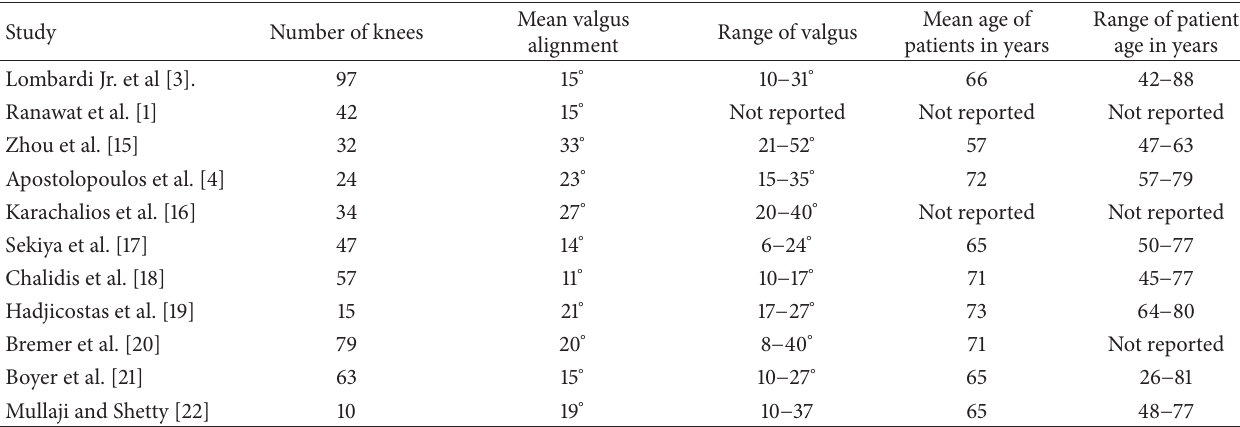
Figure 5: Postoperative Range of Motion (ROM) flexion (a) of 110 ∘ and extension (b) 0 ∘ . Table 1: Studies reporting TKA in valgus osteoarthritis showing the mean valgus and patient